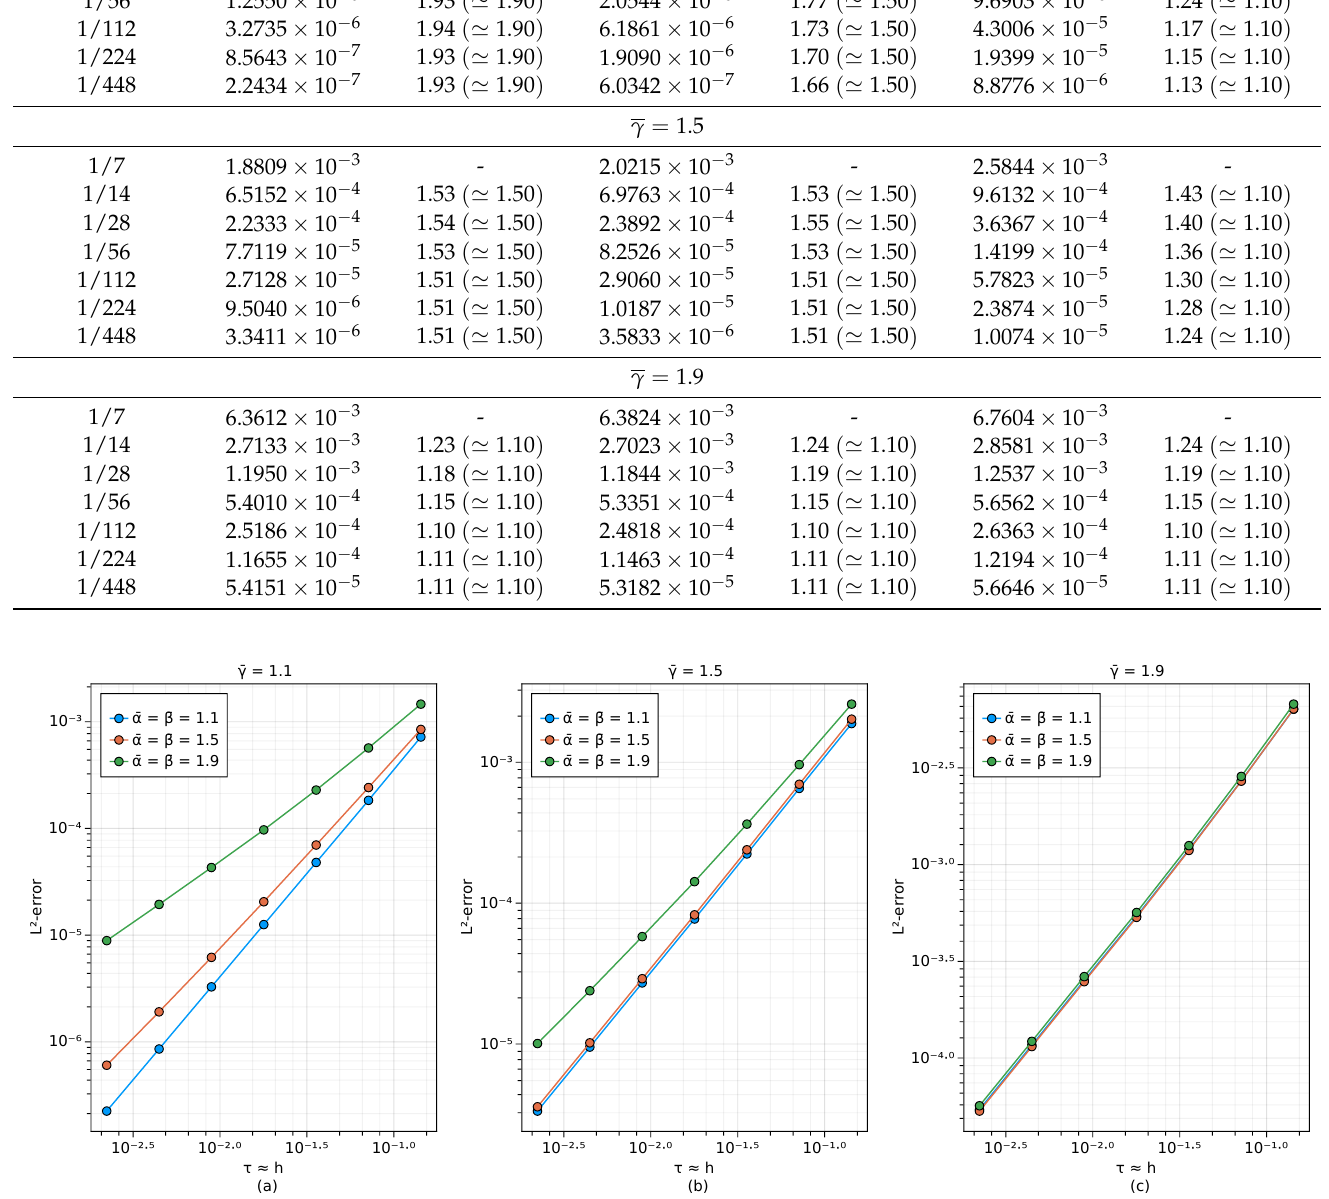
Table 1. L 2 -errors, E 1 , i ≥ 1 calculated by (54) and convergence orders, R 1 N i (56) for different values of τ i ≈ h i , N i = 1/ τ i . The numbers in parentheses indicate the theoretical convergence order.